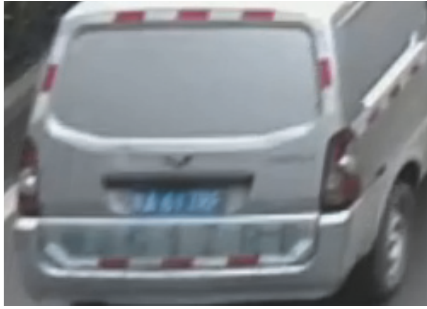
Figure 33: The inverse projection of the main view of van.